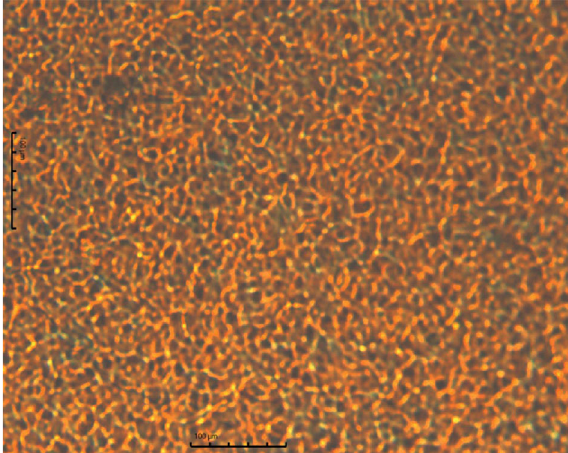
Figure 6: Polarized optical microscope of a dried fi lm, seen under crosspolarizers. Scale bar is 100 μ